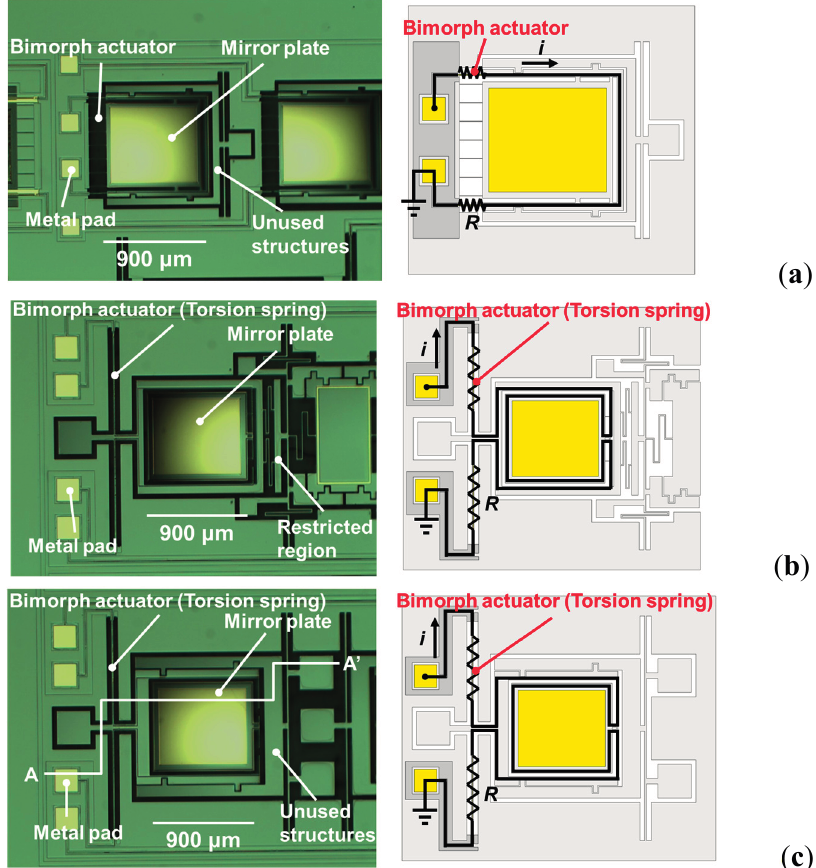
Figure 2. Photos of the three different electrothermally-actuated MEMS mirrors: